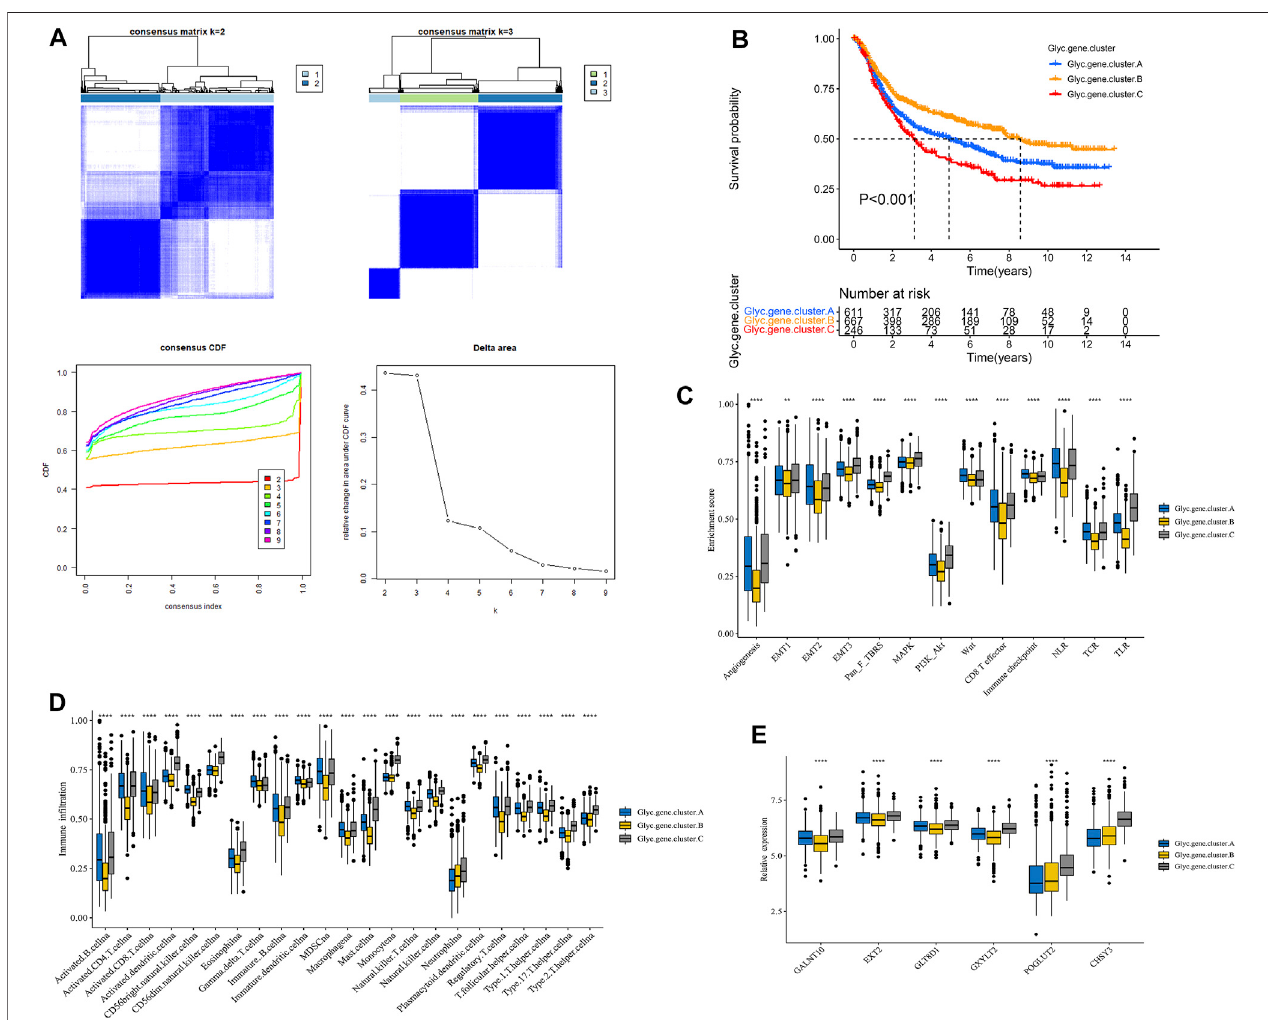
FIGURE 4 | Construction of Glyc. gene signature. (A) Unsupervised consensus clustering based on prognostic Glyc-related differentially expressed genes to classifypatientsintothreegroupstermedGlyc.gene.clustersA,Glyc.gene.clustersB,andGlyc.gene.clustersC. (B) Kaplan – Meiercurveshowedasigni fi cantdifference between the three Glyc. gene.clusters. (C) Differences in stroma-activated pathways including EMT, TGF beta, and angiogenesis pathways among three Glyc. gene.clusters. (D) The abundance of each TME in fi ltrating cell in three Glyc. gene.clusters. The upper and lower ends of the boxes represented the interquartile range of values. The lines in the boxes represented median value, and black dots showed outliers. (E) The expression of six Glyc regulators in three Glyc. gene.clusters. The upper and lower ends of the boxes represented interquartile range of values. The lines in the boxes represented median value, and black dots showed outliers. The asterisks represented the statistical p -value (* p < 0.05; ** p < 0.01; *** p < 0.001; **** p < 0.0001).